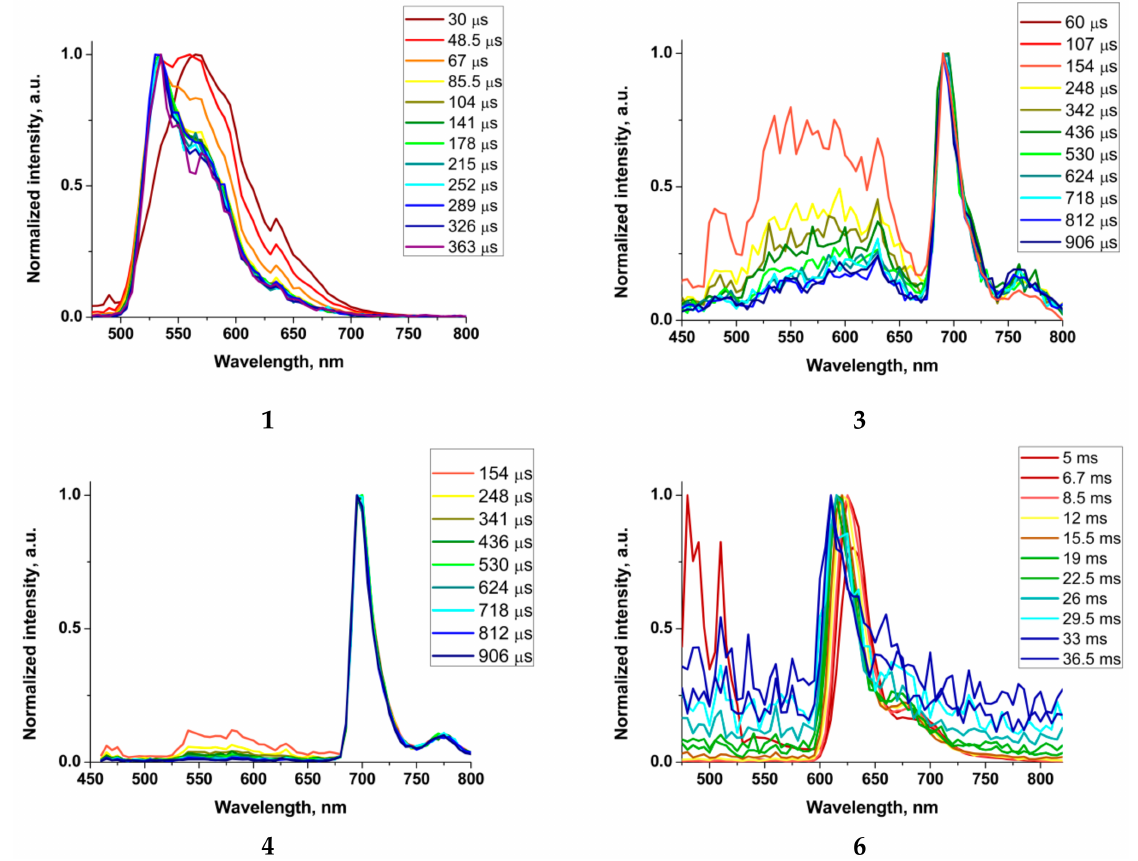
Figure 7. Time-resolved emission spectra for 1, 3, 4 and 6 in the rigid matrix MeOH:EtOH (1:4) at 77K (Excitation wavelength 405